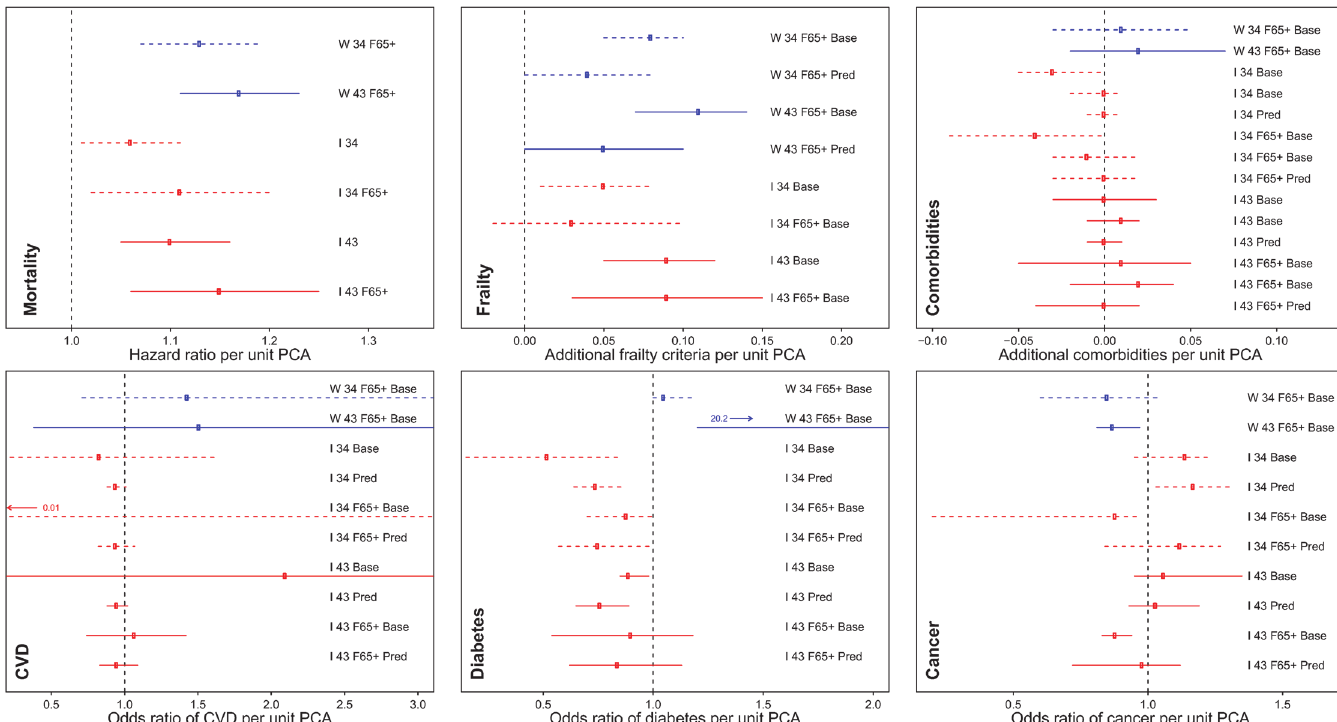
Fig 11. Point estimates with 95% CIs for regression models predicting health outcomes based on PCA1. Blue indicates WHAS and red indicates InCHIANTI. Solid lines are for 43-variable models and dashed lines for 34-variable models. W or I for WHAS or InCHIANTI respectively; 34 or 43 for the number of variables; F65+ if the model only included women aged 65+ (all models for WHAS); Base if the model was a cross-sectional analysis of baseline values, and Pred for models predicting a change in the parameter at the subsequent visit. Poisson regressions not shown; see S1